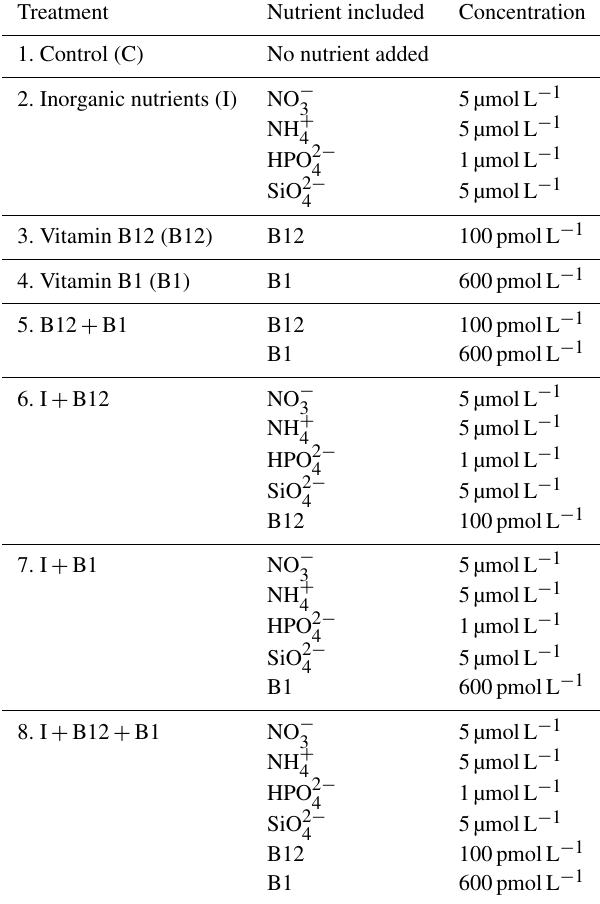
Table 1. Eight different treatments were applied consisting of the (1) control treatment (C): no nutrients added; (2)